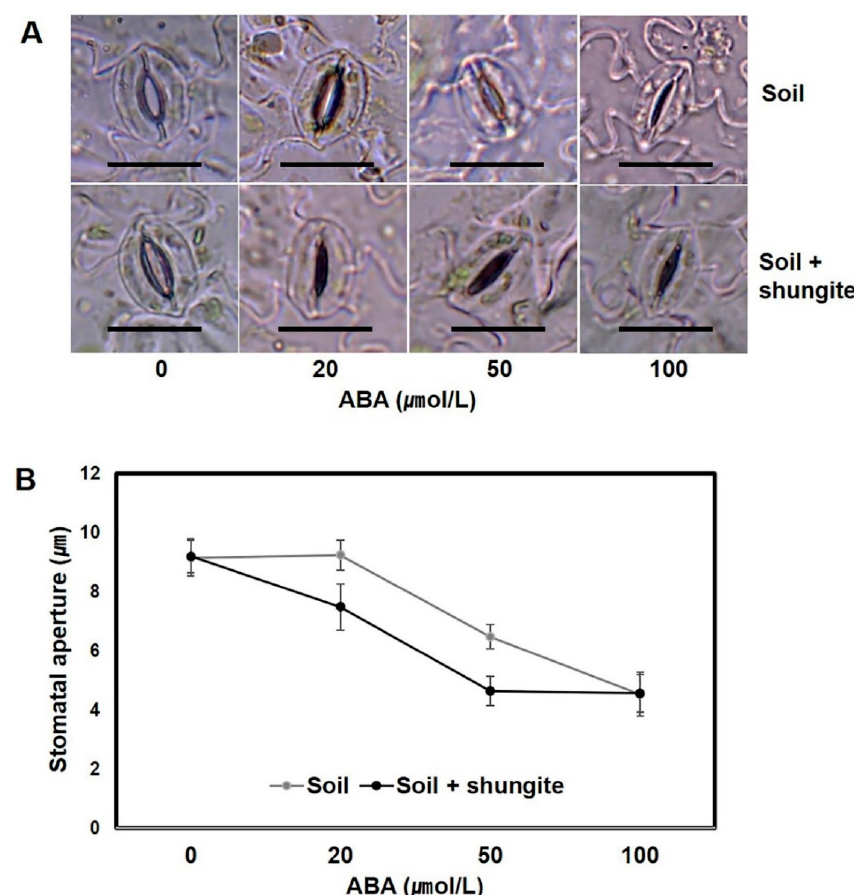
Figure 5. Effect of shungite on the sensitivity of the stomatal aperture to ABA. ( A ) The effect of ABA concentration on stomatal aperture in detached abaxial epidermal strips. Scale bar = 20 µm. ( B ) Data are represented as the mean of 15 randomly selected stomata from three biological replicates (±SD). Different letters indicate significant differences (Student’s t- test, P ≤ 0.05). ABA: abscisic acid.